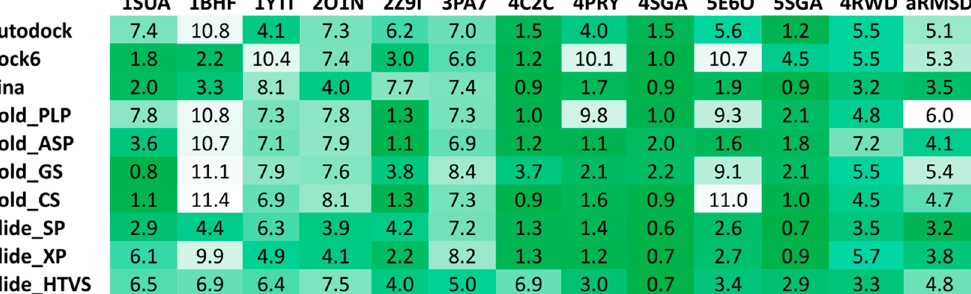
Figure 4. Results of the docking reliability analysis. The root-mean square deviation (RMSD) results obtained for the self-docking studies are shown in the color scale from green (low values) to white (high values).